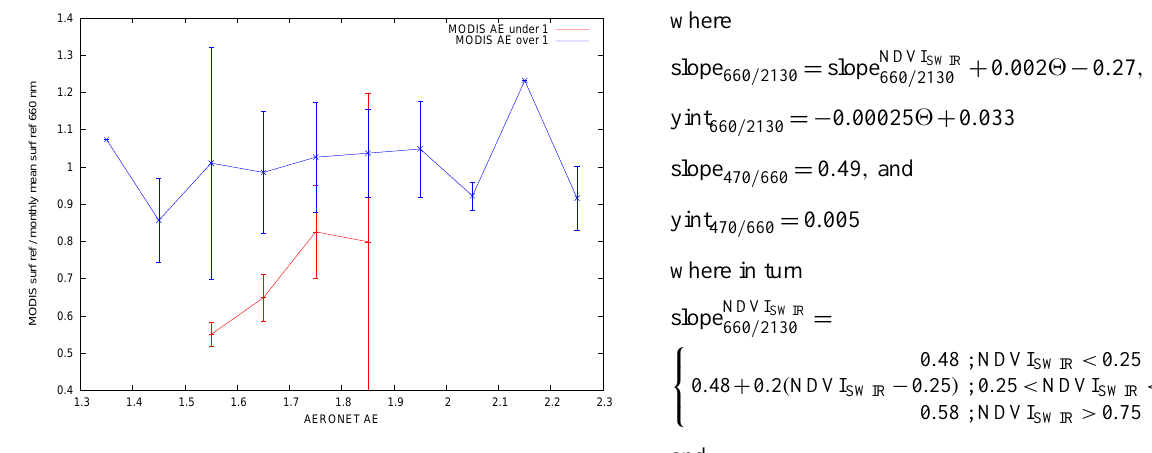
Fig. 4. MODIS surface reflectance at 660 nm, normalized with monthly mean values as a functionofAERONETAE.AllavailablemeasurementsfromMonguwereused. Measurements with MODIS AE over (blue) or under (red) than 1 are shown separately. Only measurements withAOD(550nm)valueslargerthan0.3(MODISandAERONET)areconsidered. Inaddition, standarddeviationsofthesurfacereflectancesinsidethebinsareshownwithbars.